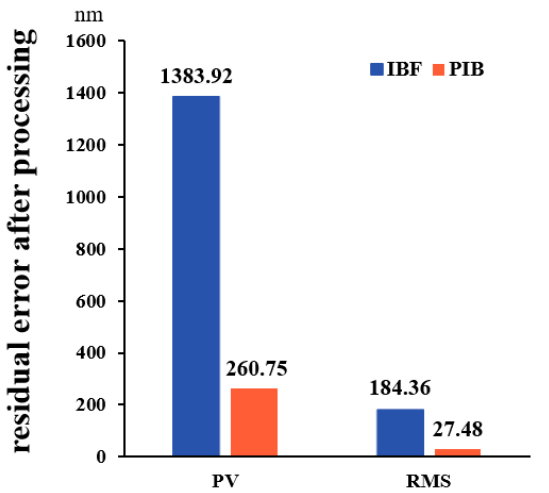
Figure 5. Comparison of the residual convergence after processing.